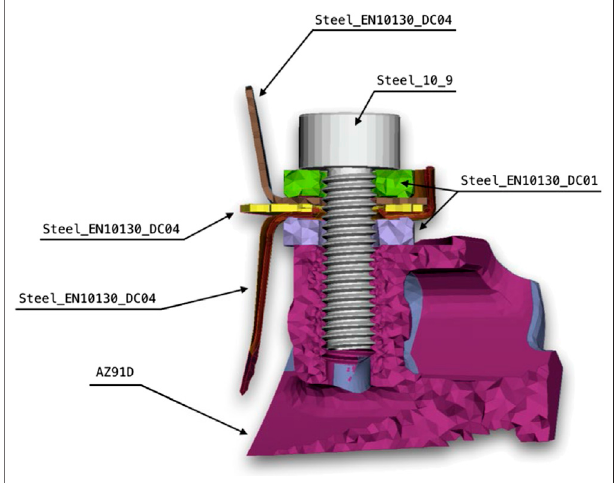
FIGURE 2 | Cut FE model of the